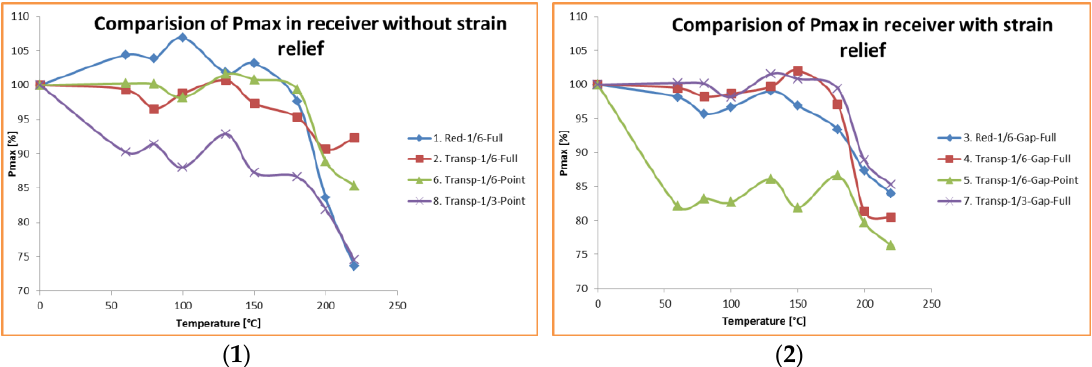
Figure 17. ( 1 ) Comparison of Pmax decrease in receivers with strain relief; ( 2 ) Comparison of Pmax decrease in receivers without strain relief.